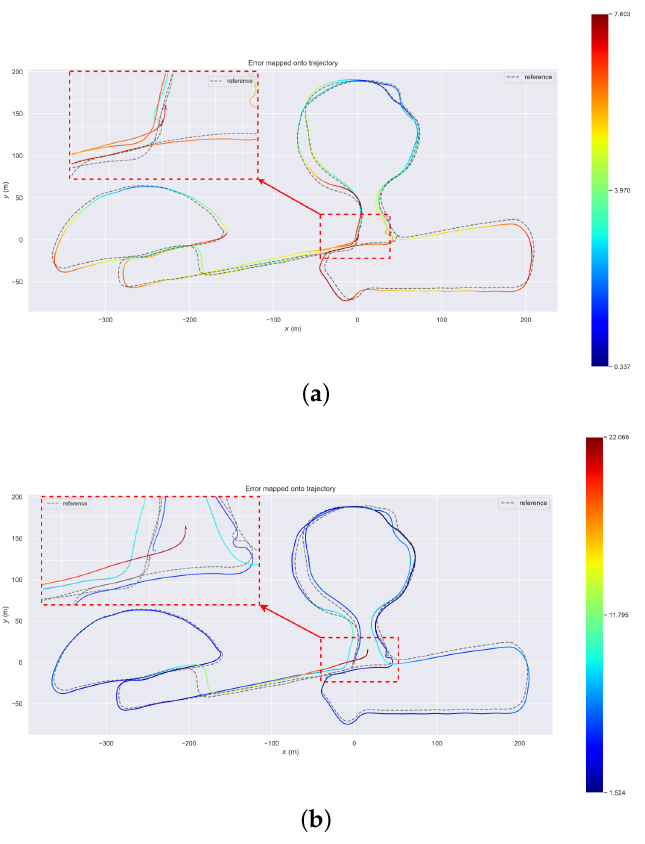
Figure 10. ( a ) The trajectory alignment of our VIS and GPS on ZJG-gym dataset. ( b ) The trajectory alignment of VINS-Mono and GPS on ZJG-gym dataset. It is clear that our VIS has a better